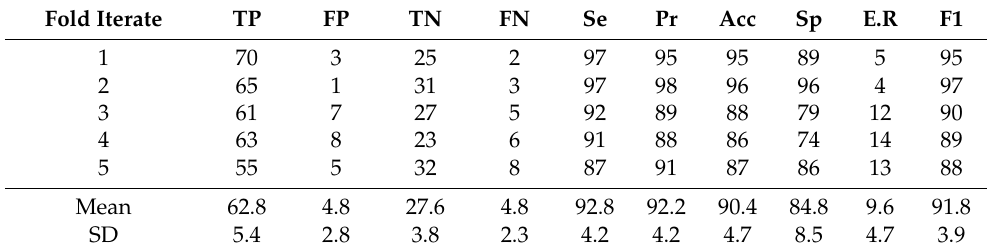
Table 3. Comparative analysis of accuracy.